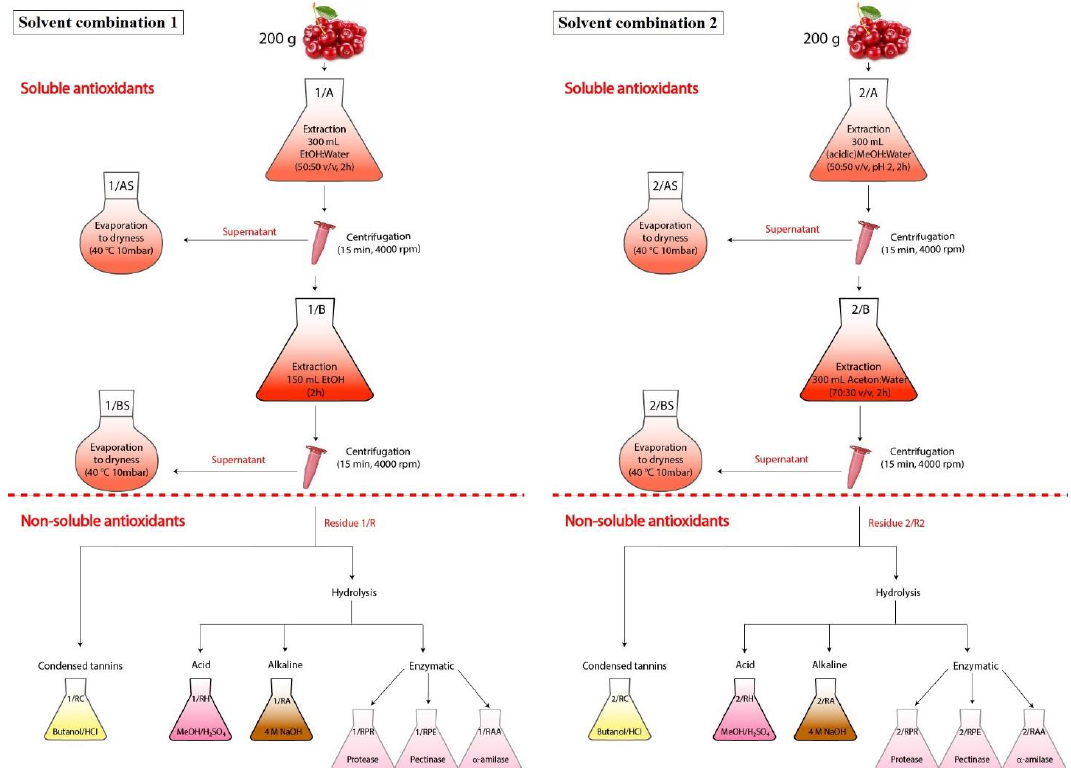
Figure 6. Scheme of the extraction of antioxidants from sour cherry. Abbreviations: 1/AS: